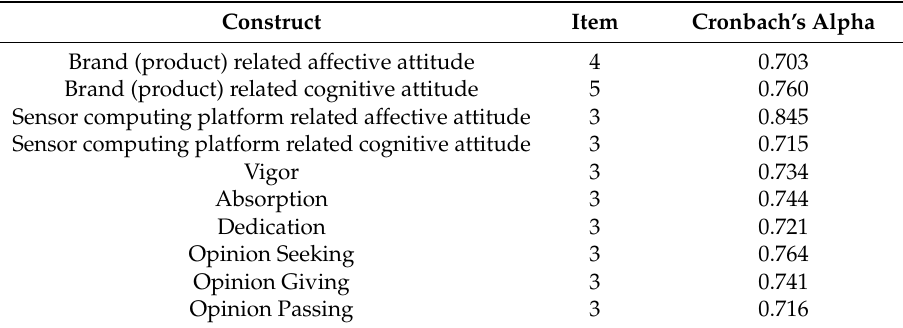
Table 3. Reliability of the research constructs.